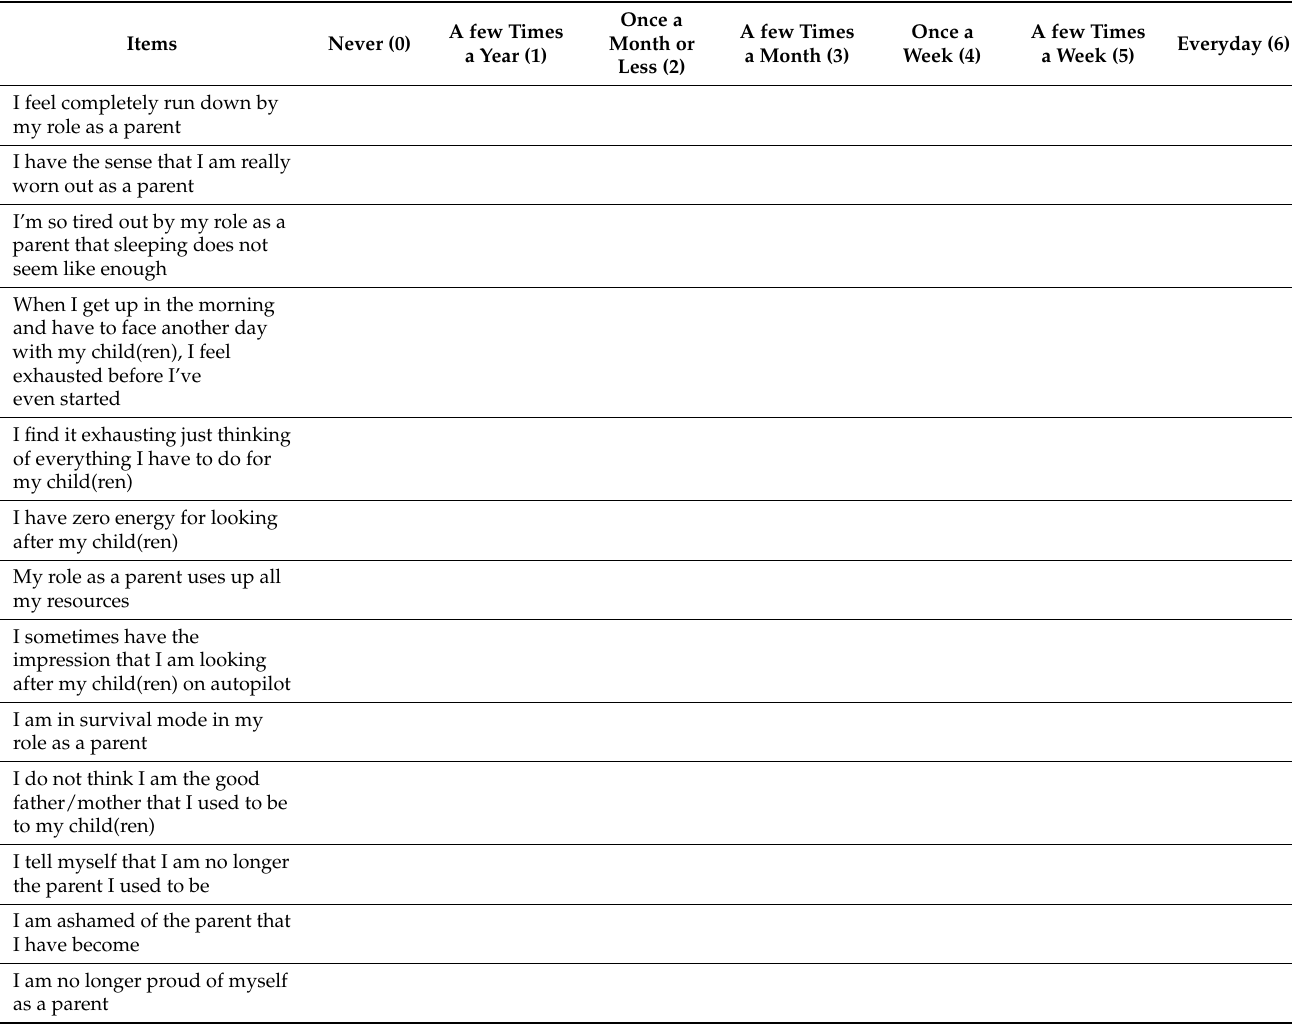
Table A2. Parental Burnout